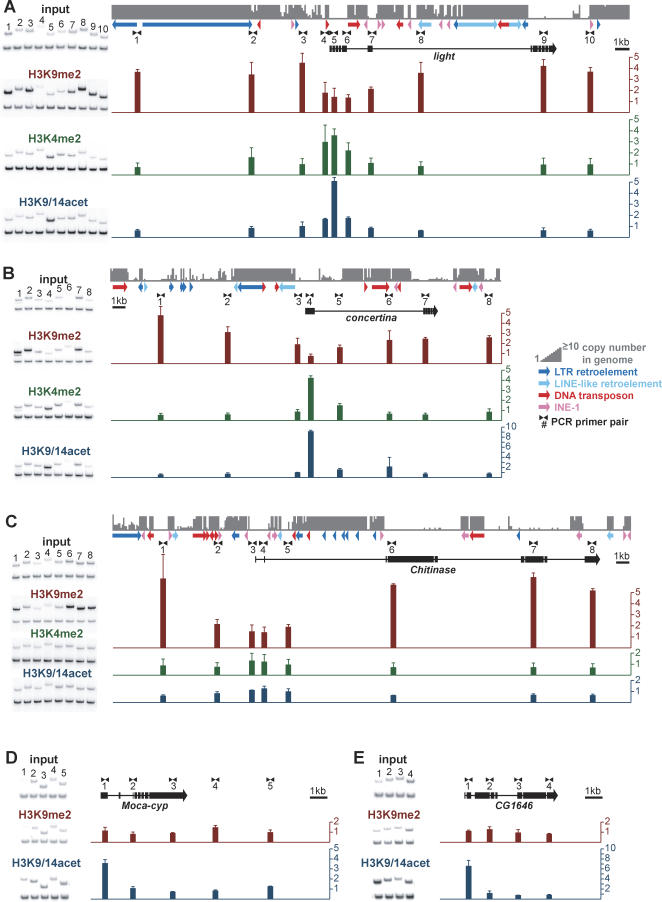
Distribution of Modified Histones in Representative Heterochromatic and Euchromatic Genes(A) ChIP results for the light gene. The top diagram summarizes gene structure, using the key shown in the figure. Gray blocks on the top line indicate whether the region is repetitive (high bar) or unique (no bar). For this diagram, non-overlapping 100 bp windows were individually BLASTed against the whole genome sequence and each hit with E < 10−3 was counted as one copy. The colored arrows show orientation and types of transposable elements located in the repetitive regions (INE-1 is a highly abundant TE that constitutes its own category). The black arrow depicts the exons (black blocks) and introns (black lines). Pairs of opposing black triangles with identification numbers show the locations of ten PCR primer pairs used in the ChIP assay. Left panels show the gel assay of quantitative duplex PCR of input or ChIP samples as indicated, with the numbers identifying the corresponding PCR primer pair used for each lane. The common bottom band in each lane is the normalization control Pdi (Materials and Methods). The bar graphs summarize ChIP results across the length of the gene (x-axis), with bar heights showing average enrichment factors (y-axis) and standard errors for three trials for H3K9me2 (top graph), and two trials each for H3K4me2 (middle) and H3K9/14acet (bottom). ChIP results for (B) concertina and (C) Chitinase with the same number of trials as described for lt. ChIP results for two euchromatic control genes, (D) Moca-cyp and (E) CG1646 with two trials each.